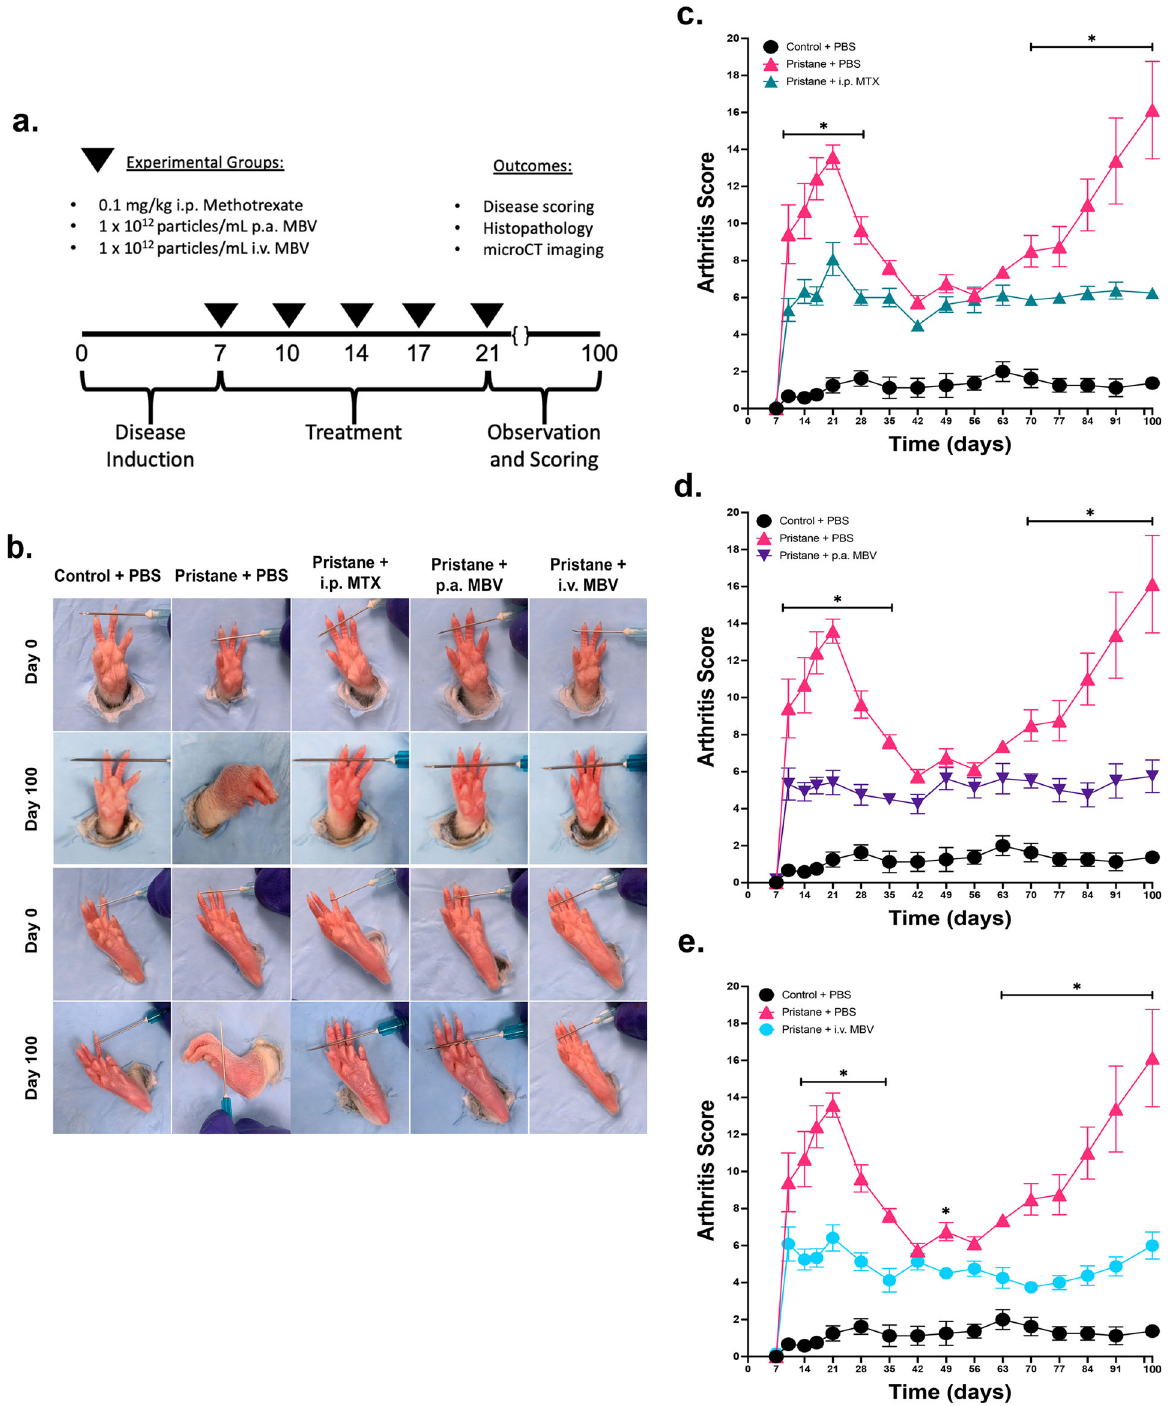
Fig. 1 Local and systemic administration of MBV signi fi cantly reduces both acute and chronic pristane-induced arthritis disease severity. a Experimental design and treatment regimen. b Representative images of forepaws and hind paws for each group at day 0 and day 100. Evident edema, erythema, and distortion of the forepaws and hind paws were evident in the Pristane + PBS group but not in the remaining treatment groups. c I.p. methotrexate signi fi cantly reduces disease scoring between days 10 – 28 and days 70 – 100 compared to Pristane + PBS ( p < .05) d P.a. MBV signi fi cantly reduces disease scoring between days 10 – 35 and days 70 – 100 compared to Pristane + PBS ( p < 0.05). e I.v. MBV signi fi cantly reduce disease scoring between days 14 – 35 and days 63 – 100 compared to Pristane + PBS ( p < 0.05). All values represented in panels c – e are mean ± s.e.m., n = 12 for days 7 – 28, and n = 8 days 28 –